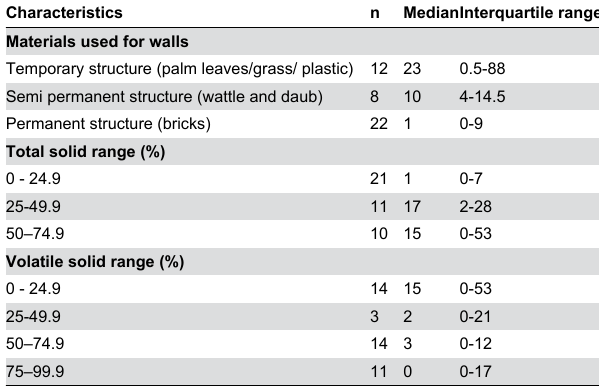
Table 5. Median number and interquartile range